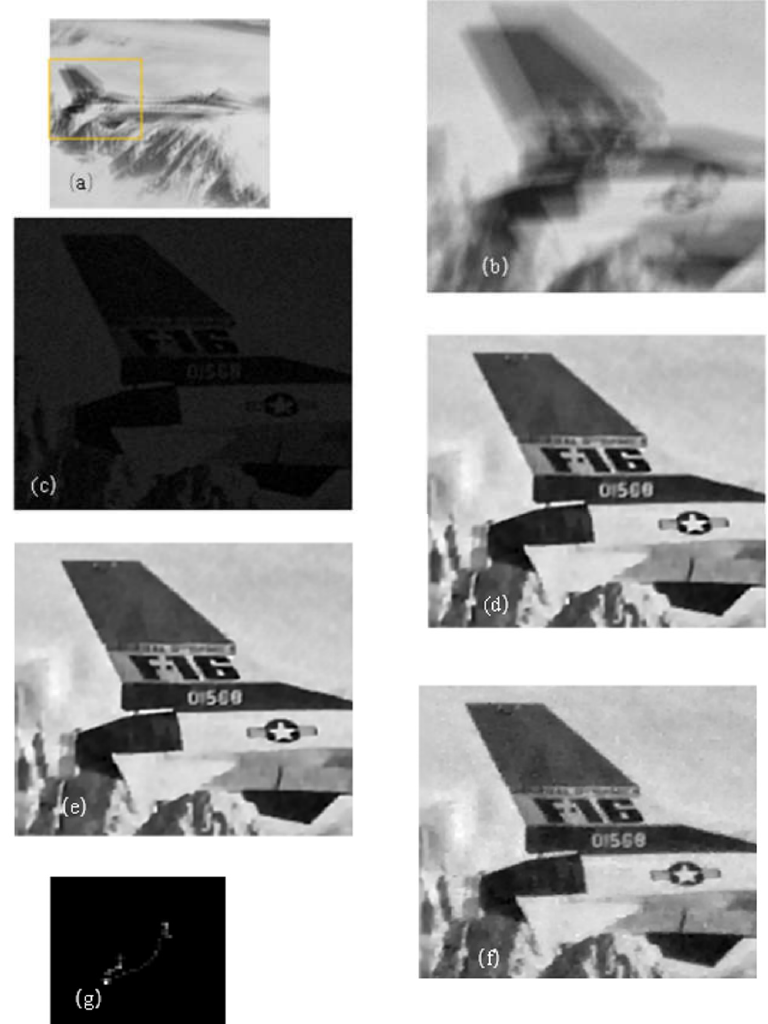
Figure 6. Remote image restoration: ( a ) blurred image; ( b ) local blurred image; ( c ) local Scheme 11.